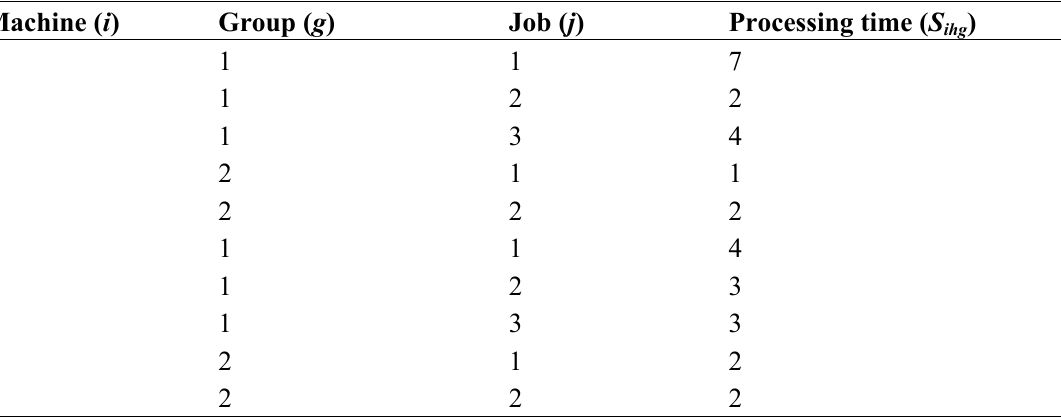
Table 2. Processing times for a Flow-Shop Sequence-Dependent Group